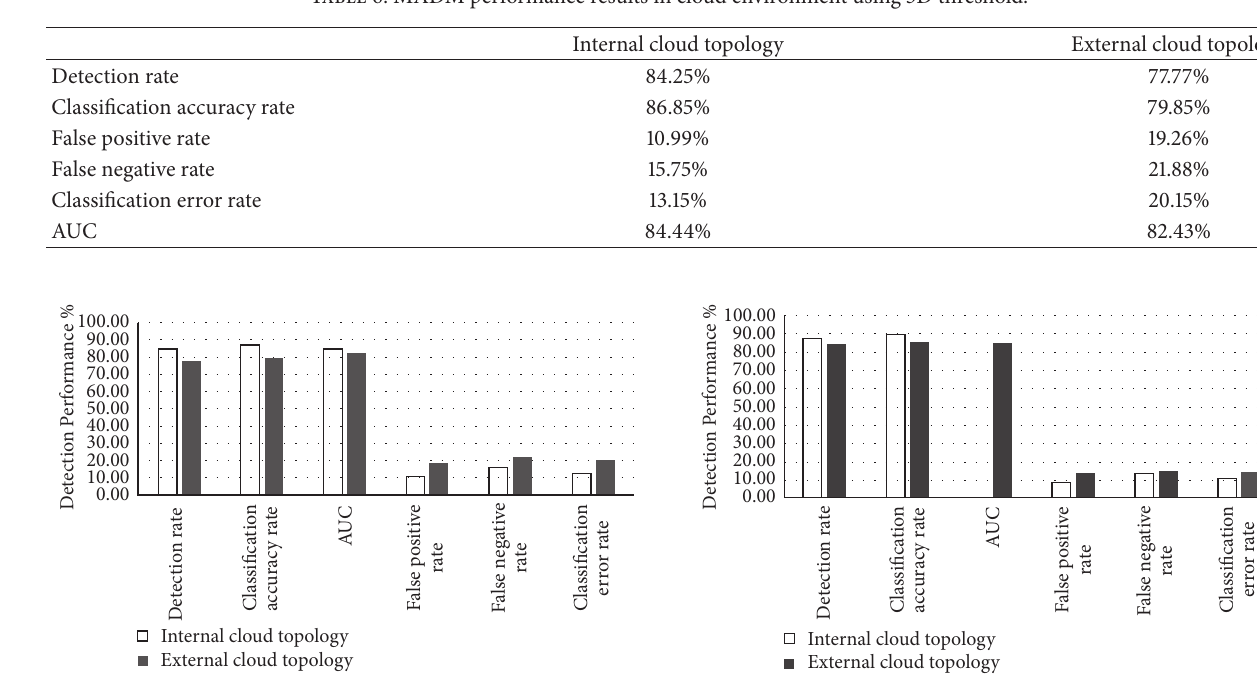
Figure 3: Cloud external flooding attacks network architecture. Table 6: MADM performance results in cloud environment using 3D threshold.